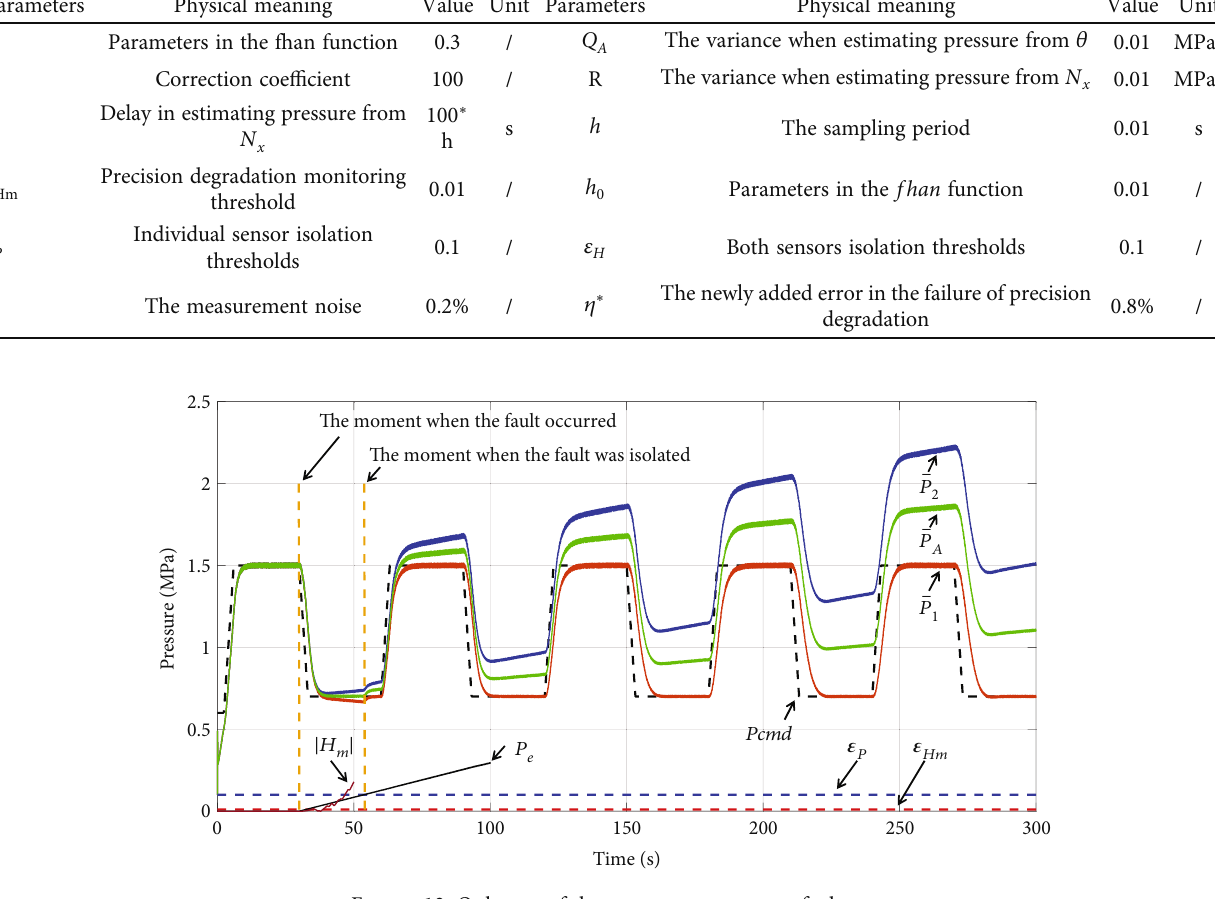
Figure 12: Only one of the pressure sensors was faulty.